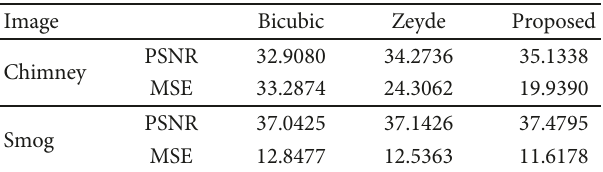
Figure 5: LR smog image and reconstructed HR image by di ff erent methods: (a) LR image, (b) reconstructed image by the bicubic method, (c) reconstructed image by Zeyde et al. ’ s method, and (d) reconstructed image by the proposed method. Table 1: Objective evaluation of the reconstructed images in Figures 4 and